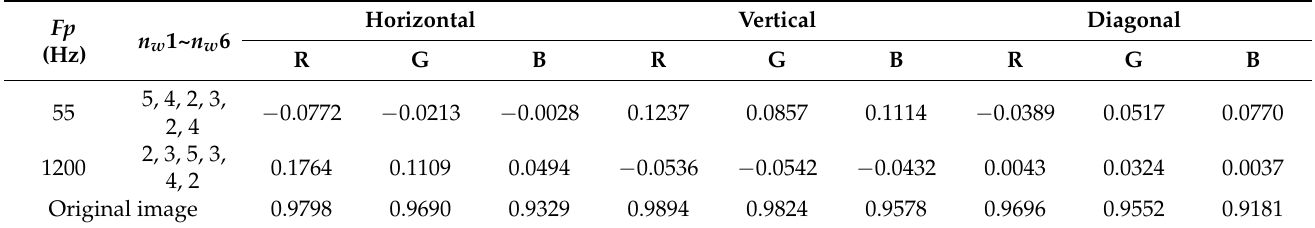
Table 4. The correlation coefficients between adjacent pixels in the plain and cipher